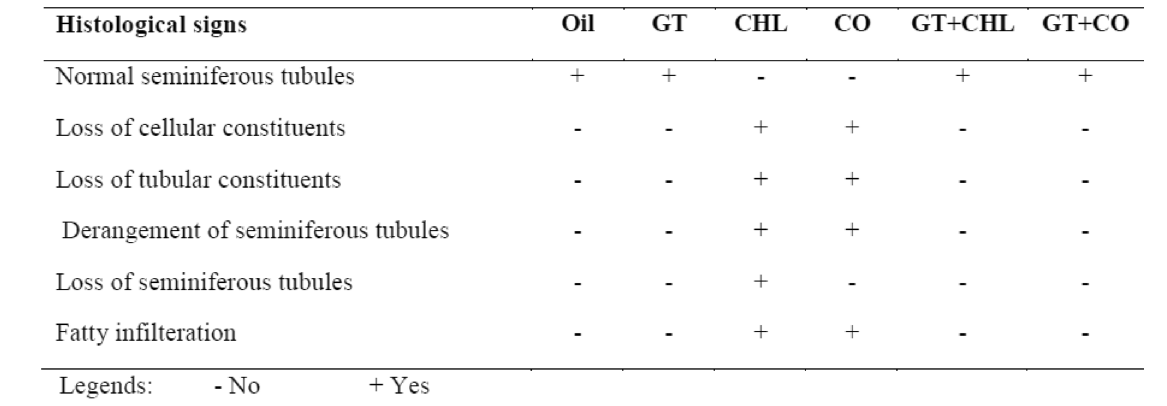
Table 1 Histological changes in testes of Wistar